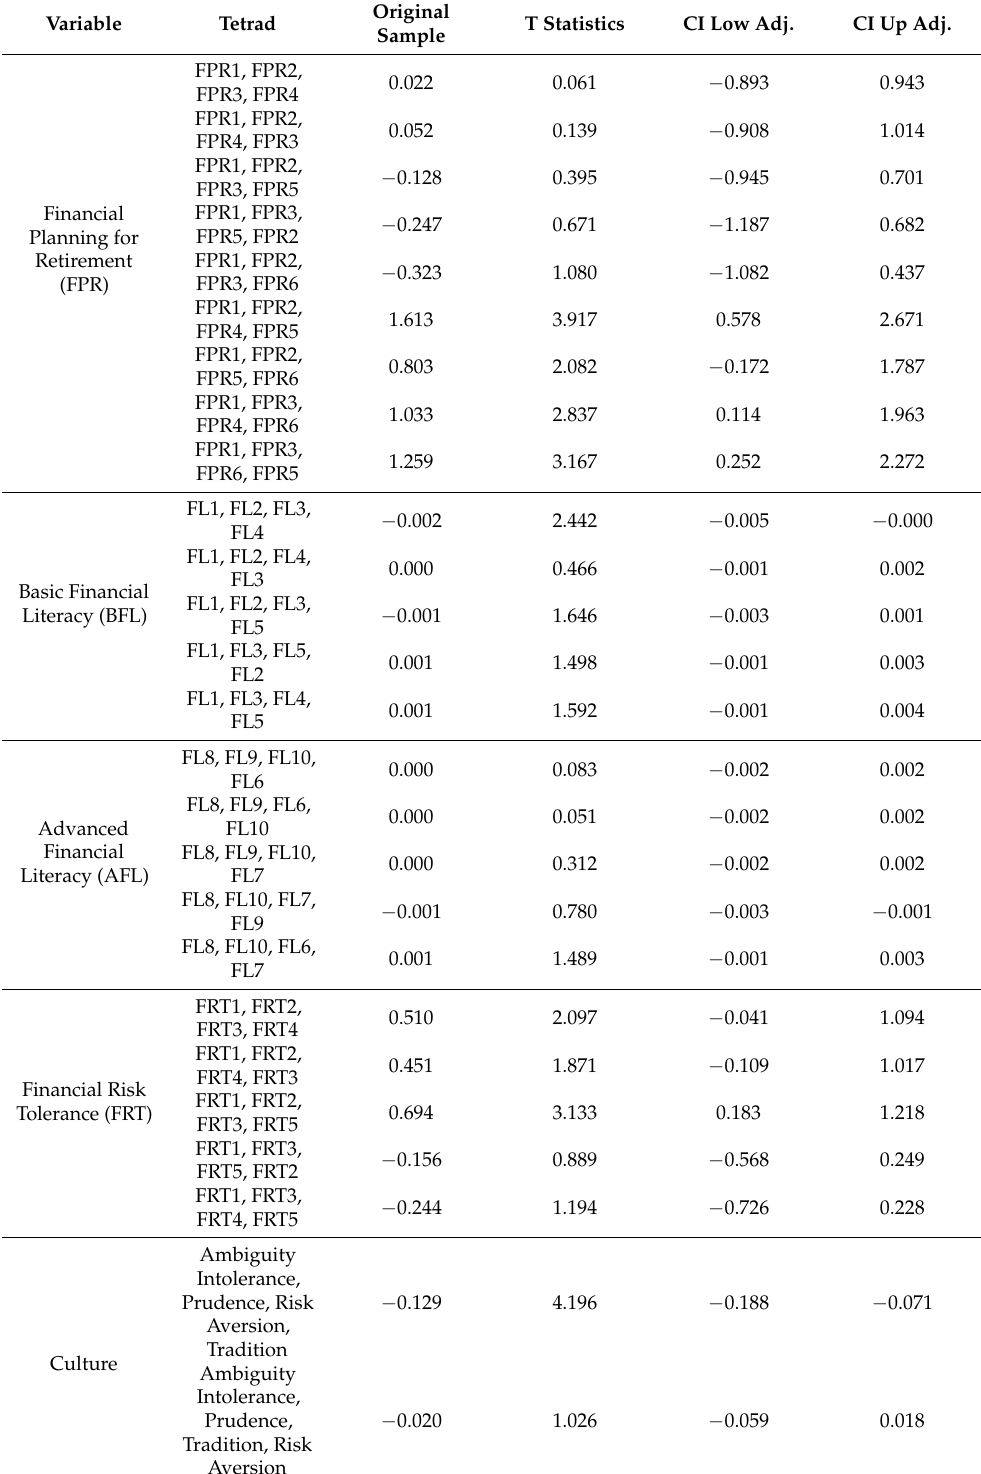
Table 4. Confirmatory Tetrad